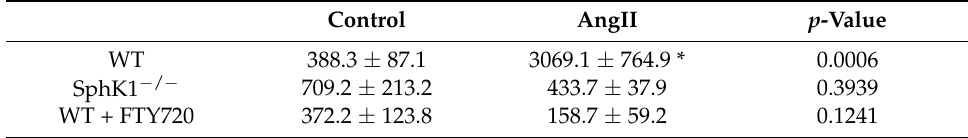
Table 2. Number of circulating S1P 1 + CD3+ T-cells. Flow cytometry-based assessment of circulating S1P 1 + CD3+ T-cell numbers in blood samples of WT, SphK1 − / − and FTY720-treated WT mice after chronic AngII or saline perfusion. Data expressed as mean ± SEM; n = 10 for WT and n = 6 for SphK1 − / − and FTY20-treated WT groups; * p < 0.05 after single unpaired comparisons.